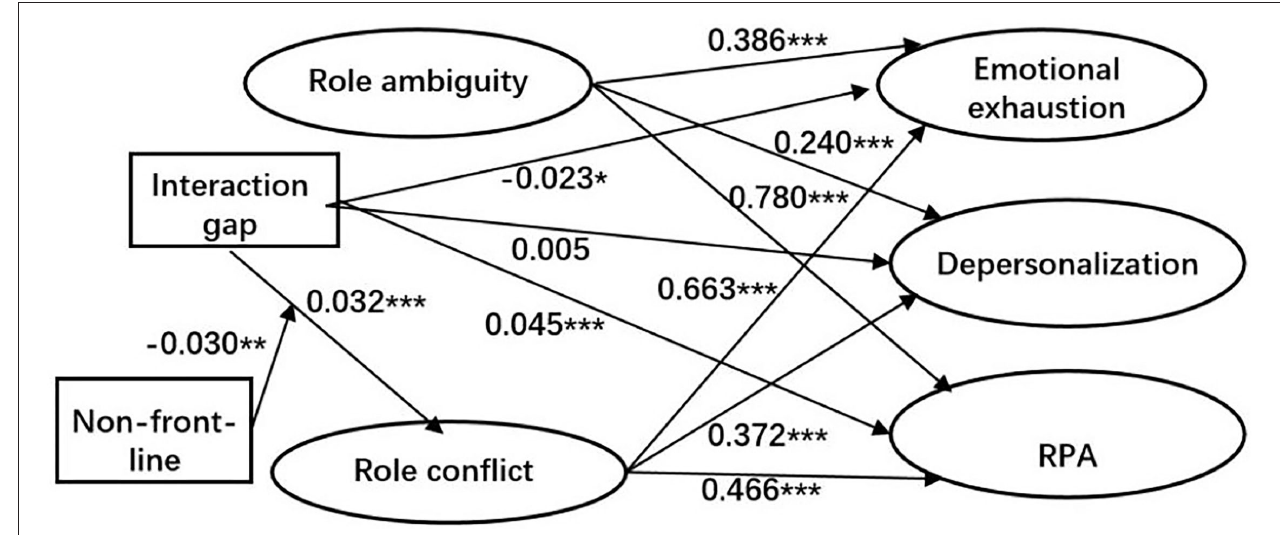
FIGURE 3 | The structural equation model of the moderated mediating effects. * p < 0.05, ** p < 0.01, and *** p <